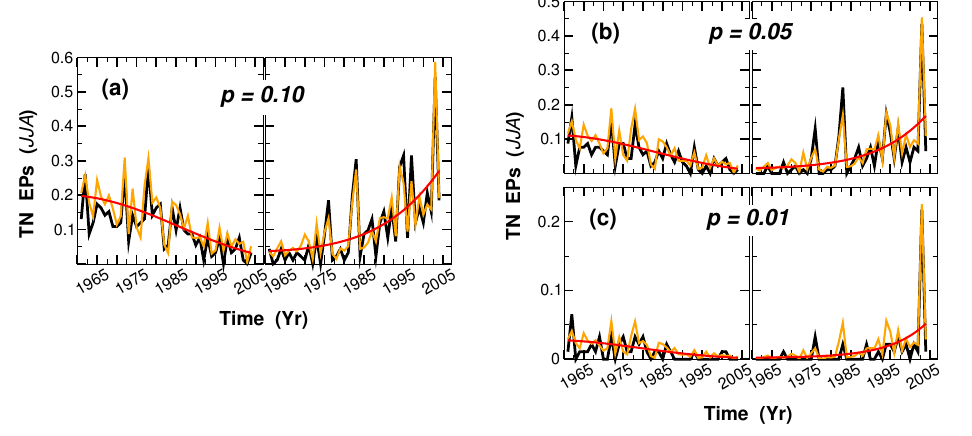
Figure 4. Same as Fig. 3, but for TN